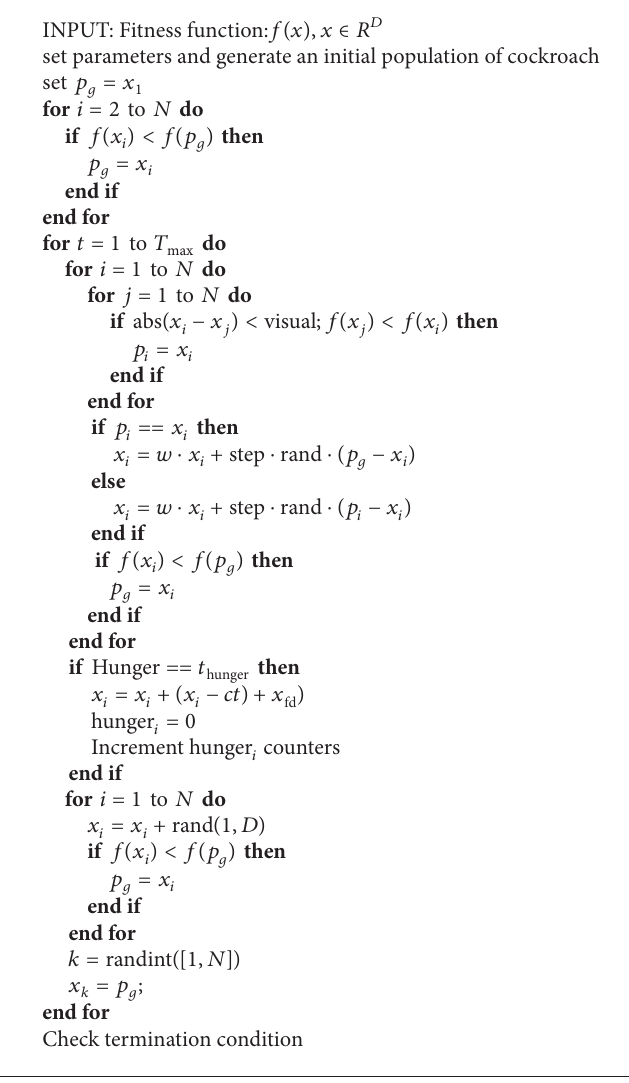
Algorithm 1: An improved cockroach swarm optimization